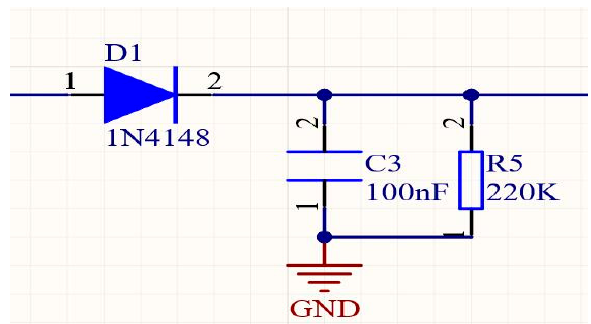
Figure 9. Envelope wave detection circuit.